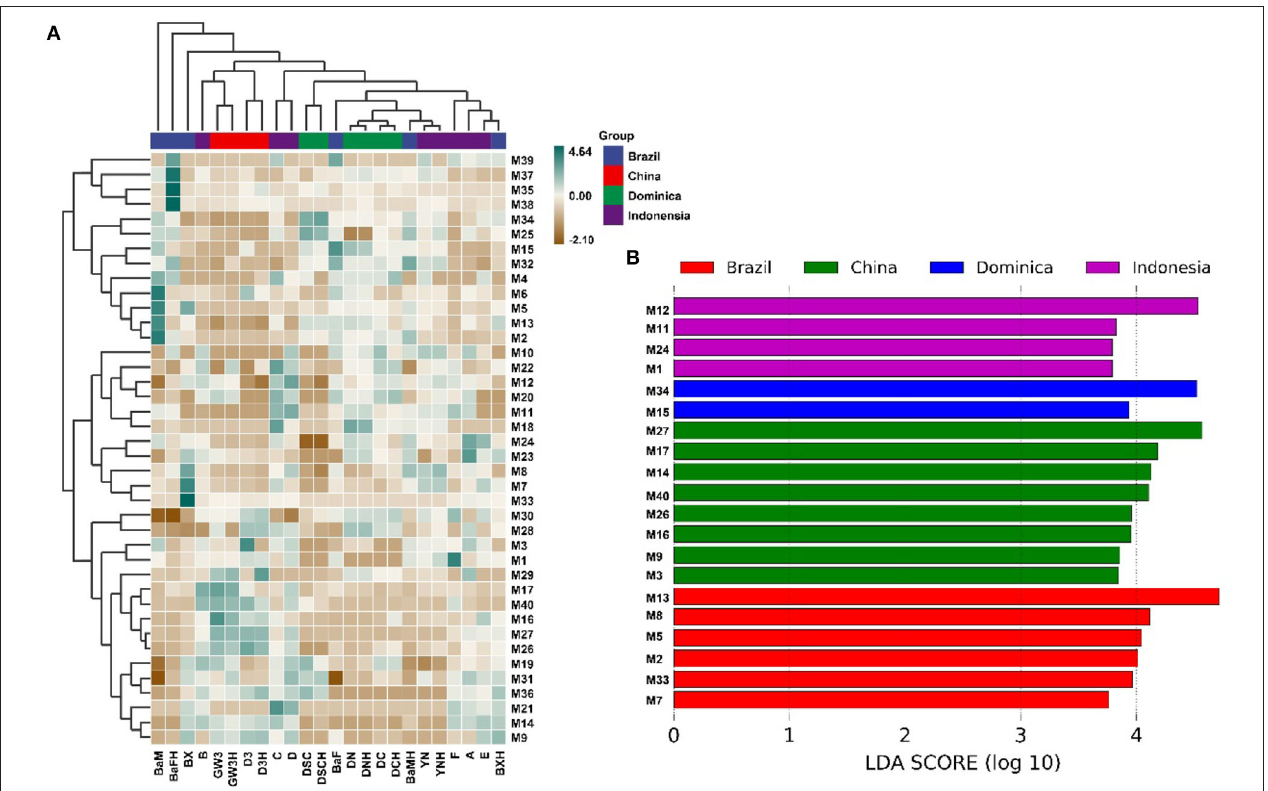
FIGURE 6 | Volatile flavor compounds in the cigar tobacco leaves. Hierarchical clustering of volatile flavor compounds in the cigar tobacco leaves (A) , Different volatile flavor compounds in different cigar tobacco leaves (B) .